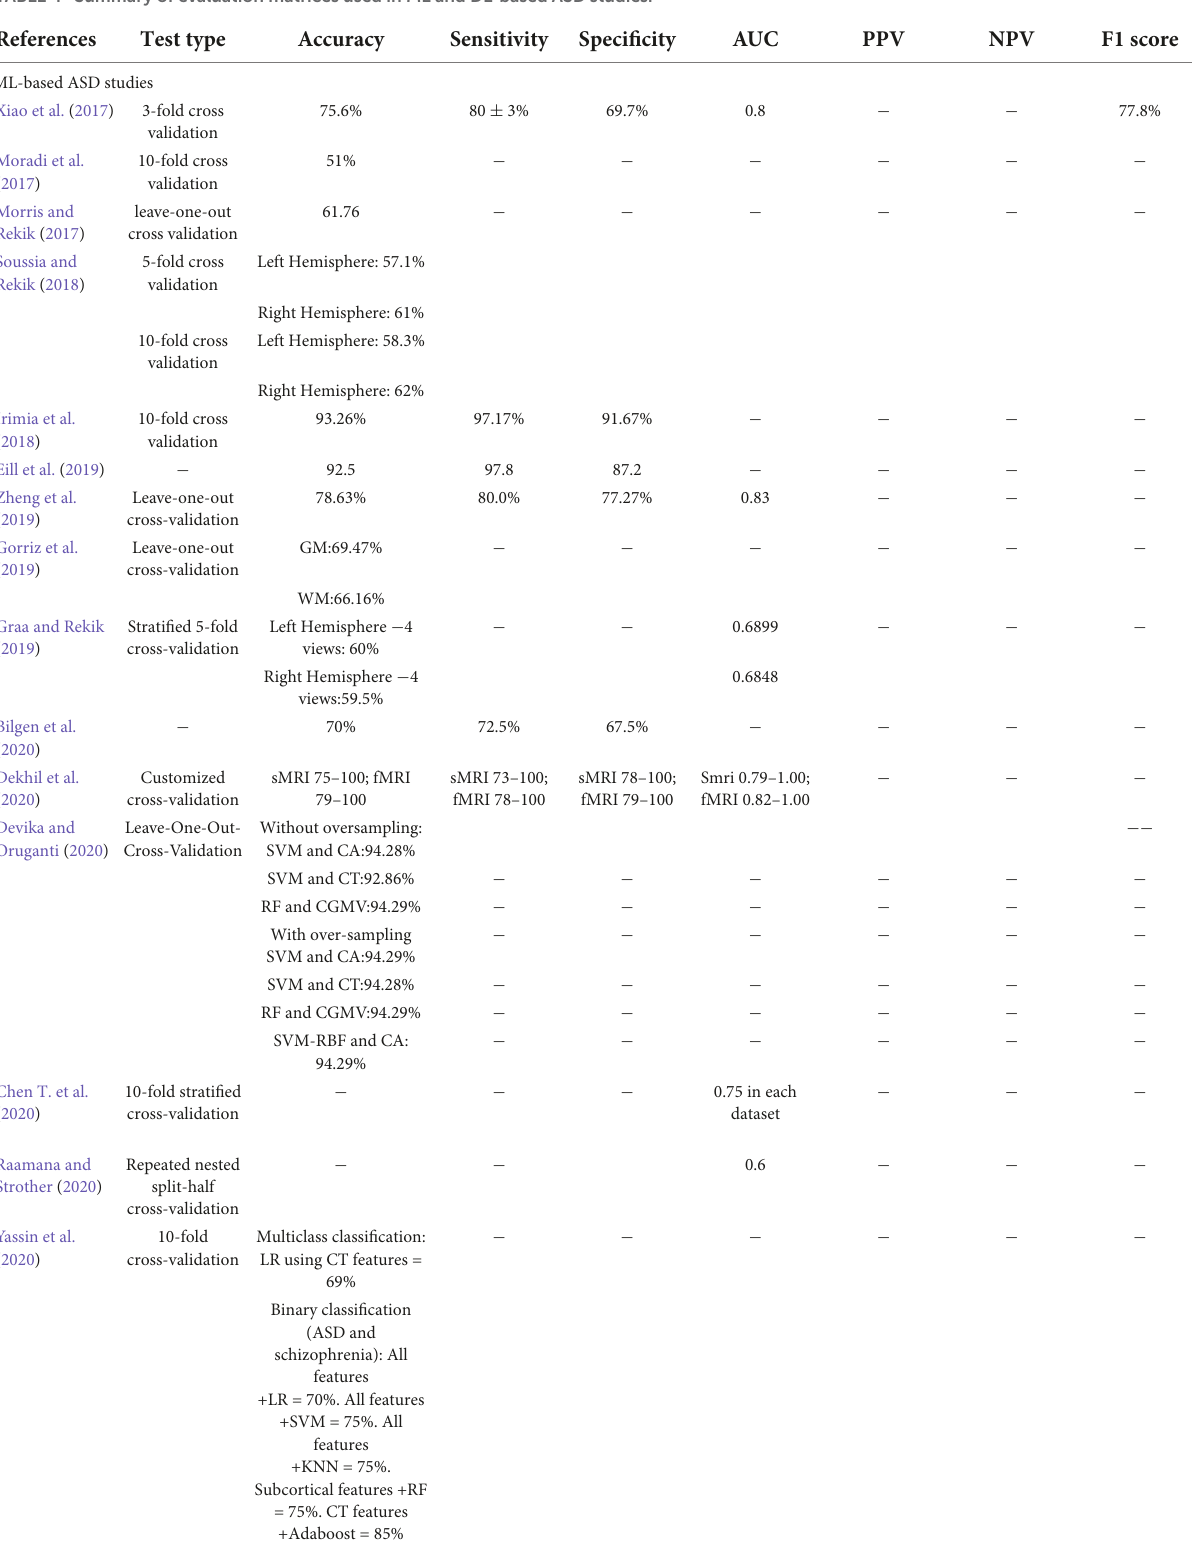
TABLE 4 Summary of evaluation matrices used in ML and DL-based ASD